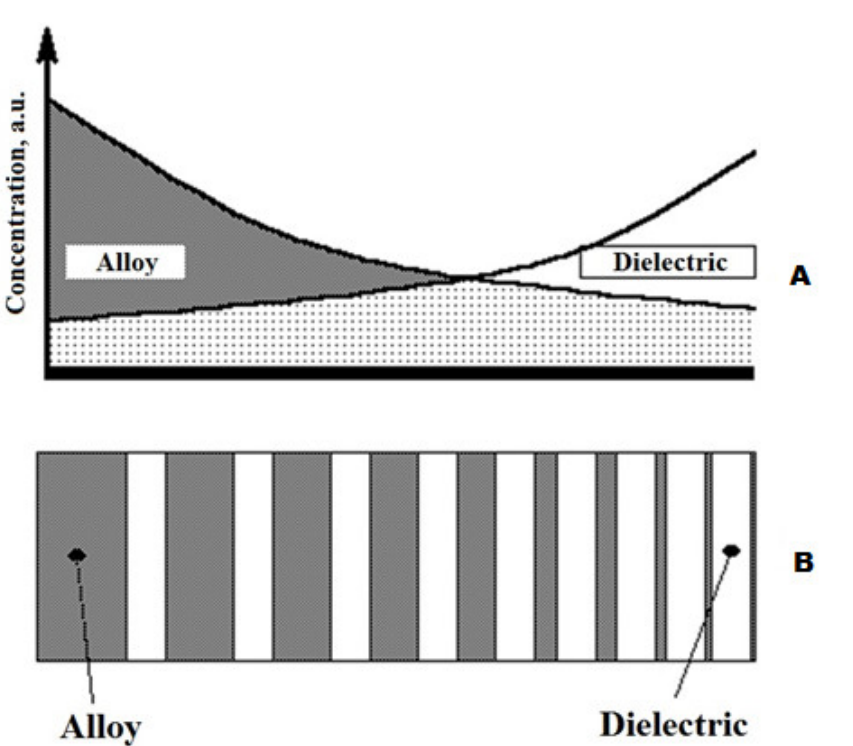
Figure 1. ( A ) A scheme for the distribution of the concentration of the composites targets components Co 45 Fe 45 Zr 10 and MgF 2 on the surface of the substrate. ( B ) A type of alloy target Co 45 Fe 45 Zr 10 with dielectric inserts MgF 2 .